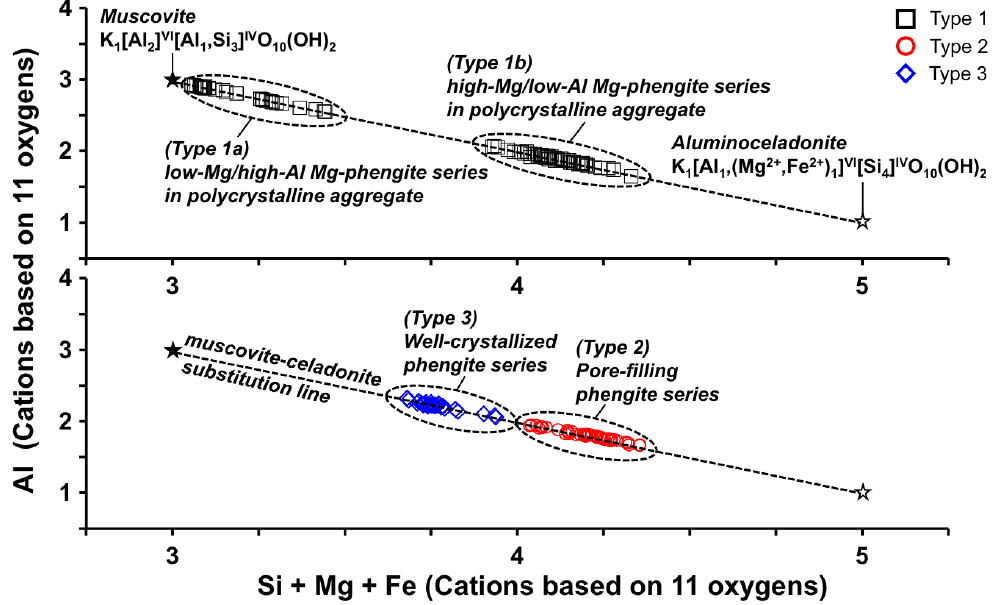
Figure 7. Plots on the diagram of Al total atoms per formula unit (apfu) versus sum of Si, Mg and Fe (apfu) for the Type 1, 2 and 3 phengites from the Haengmae Formation. The dashed line indicates the theoretical hetero-valence substitution of Al VI Al IV ↔ (Mg,Fe) VI Si IV for charge-balancing in the phengite-series solid solution.